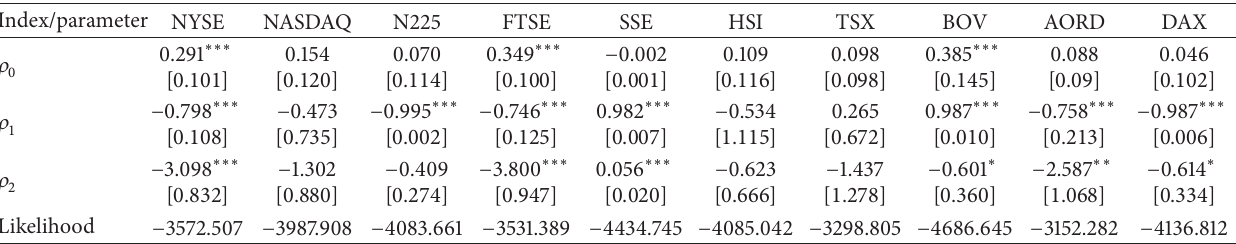
Table 3: Results of TVRA-GARCH-M model (MIX).